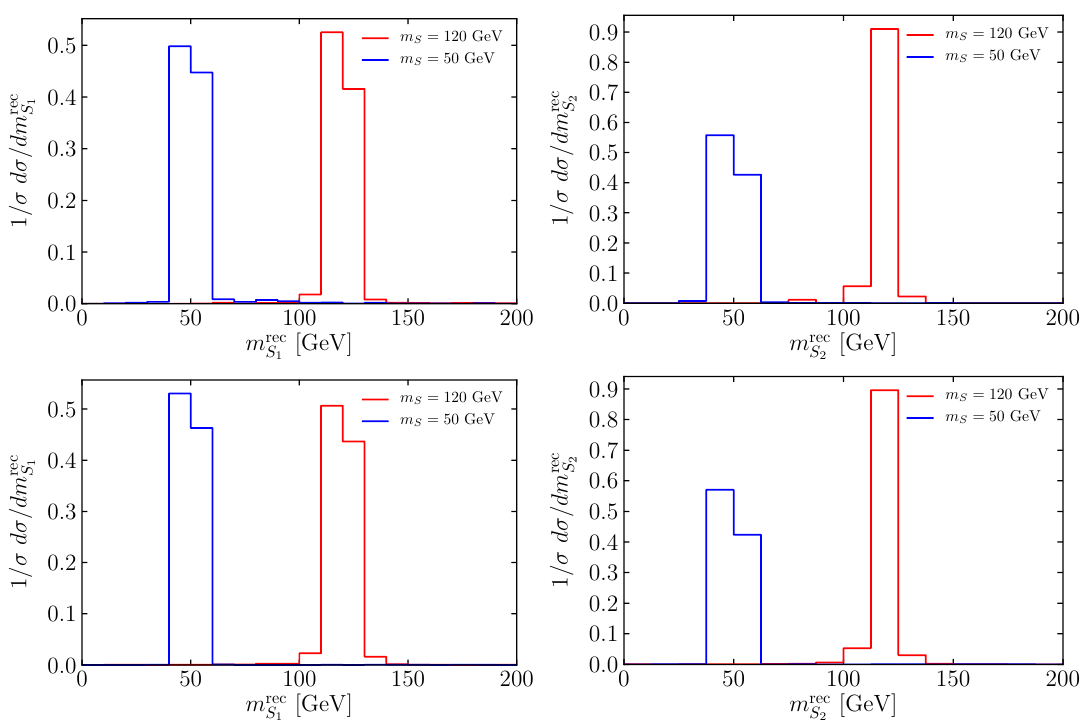
Figure 8 . The two reconstructed scalar masses, m rec t ! SSq; S ! (cid:22) + (cid:22) (cid:0) . In the upper (bottom) panel, q = c ( u ). The distributions assume a collected luminosity of L = 150 fb (cid:0) 1